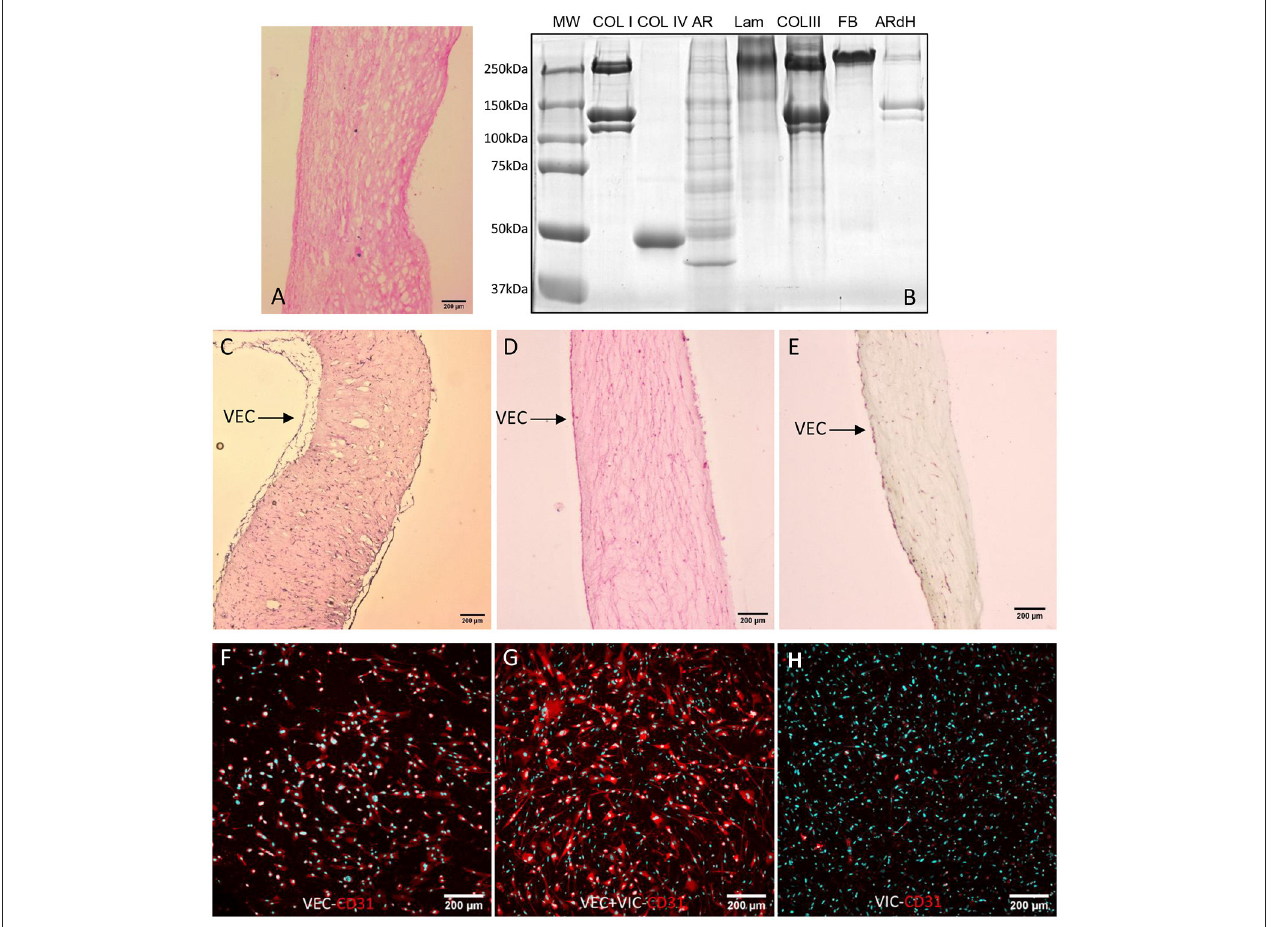
FIGURE 1 | Characterization of ARdH 3D model. (A) Histological evaluation by hematoxylin-eosin staining of decellularized aortic root tissue (10X magnification). (B) Coomassie staining of 8% Laemmli SDS-PAGE. Lane 1 – molecular weight marker; lane 2 – collagen I (Coll I); lane 3 – collagen IV (Coll IV); lane 4 – porcine aortic root before decellularization (AR); lane 5 – laminin (Lam); lane 6 – collagen type III (Coll III); lane7 – fibronectin (FBn); lane 8 – ARdH. Cross-sections of ARdH populated with valvular cells and stained with (C) Hematoxylin-eosin, (D) Picrosirius red and (E) with Movat Pentachrome. CD31 expression in VECs (surface of ARdH) (F) , VECs/VIC (Z-stack reconstruction) (G) and VICs (inside ARdH); (H) Immunofluorescence staining of CD31 (red) and nuclei DAPI-cyan, after 24h of culture. Z-stack confocal